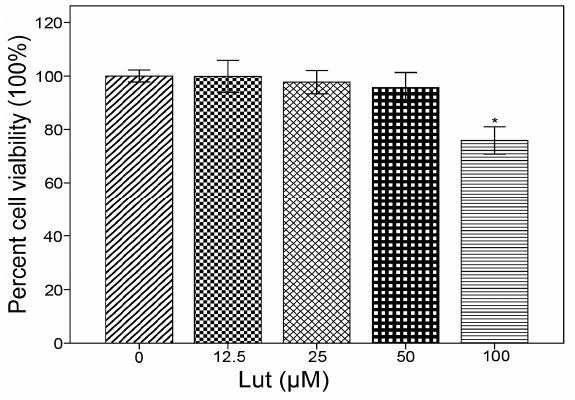
Figure 2. MTT assay BMM were incubated with concentrations of luteolin (12.5, 25, 50 and 100 μ M) for 12 h, and then the absorbance of value of each group was measured by